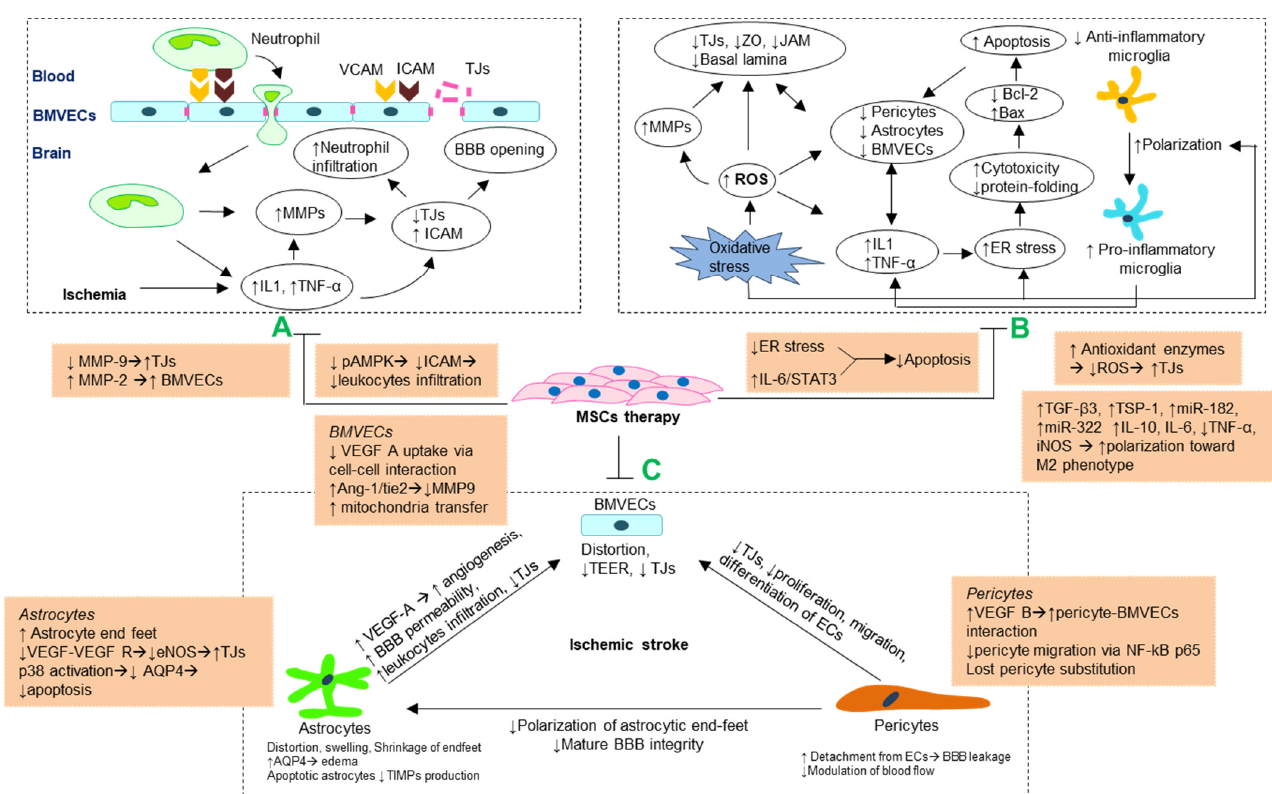
Figure 2. Schematic illustration of the major molecular mechanisms of ischemia-induced BBB disruption. ( A ) MMP regulation and attenuating leukocytes infiltrations. ( B ) Antioxidant and anti-inflammatory mechanism (comprising antioxidants, polarization toward anti-inflammatory macrophage and anti-apoptosis). ( C ) Stabilizing morphology and crosstalk of cellular components in BBB.